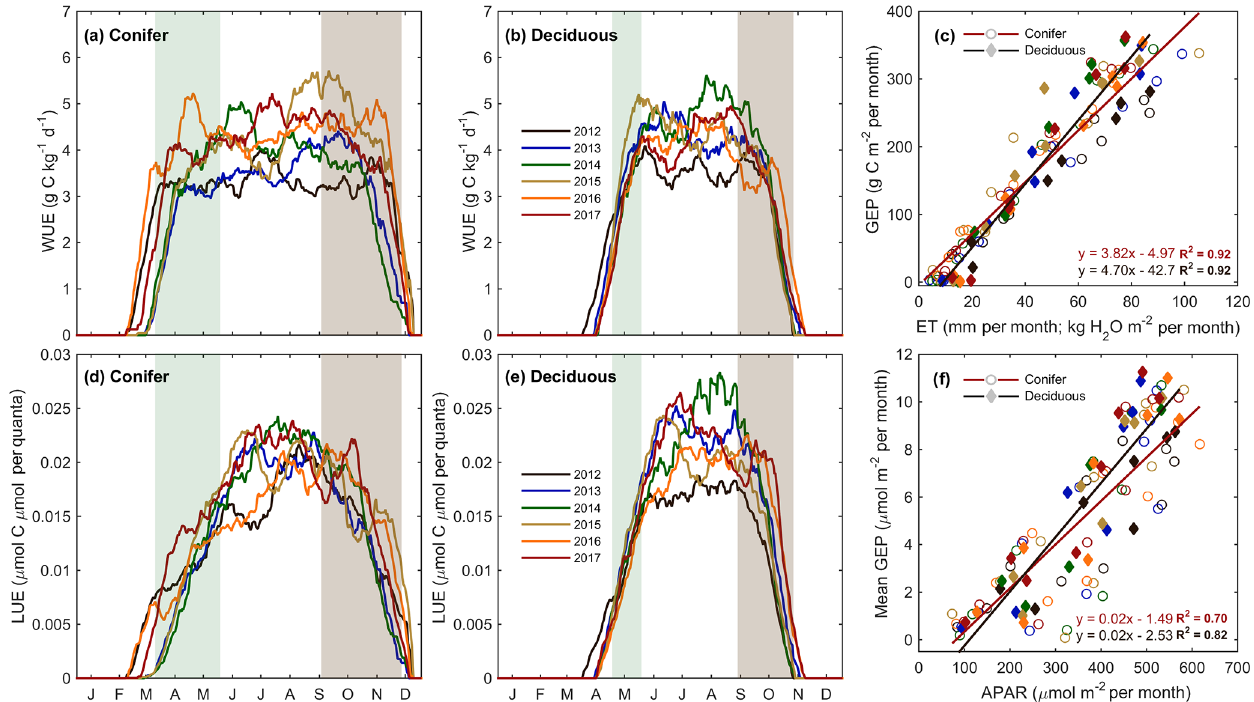
Figure 6. Annual smoothed (1-month moving average) time series of the (a) conifer (TP39) and (b) deciduous forest water use efficiency (WUE; GEP ET − 1 ), and (c) monthly linear relationships between GEP and ET at both sites from 2012 to 2017. Similarly, light use efficiency (LUE; GEP APAR − 1 ) calculations are shown for (d) conifer and (e) deciduous forests, with linear relationships (f) of monthly GEP and APAR also shown. Green and brown shading corresponds to site-specific 6-year mean phenological spring and autumn periods (Table 2), respectively. Linear fit equations and R 2 values also shown (c, f)